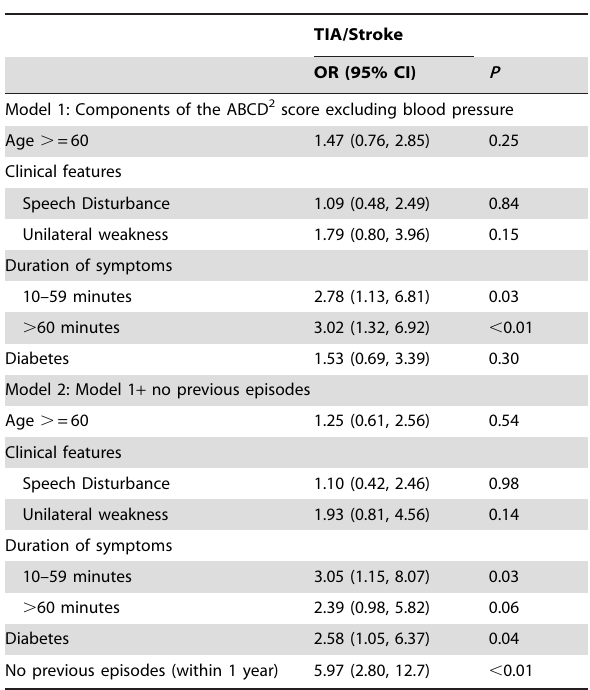
Table 3. Multivariable Predictors of TIA/Stroke Diagnosis Among 175 Users Searching for Information on Transient Ischemic Attack or Mini-Stroke Symptoms